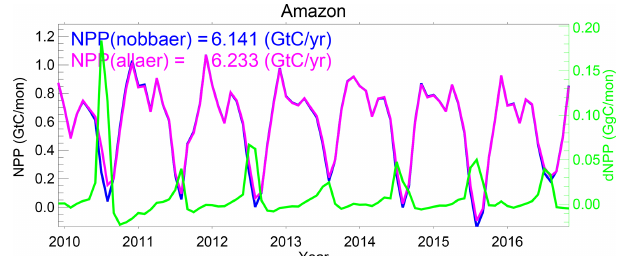
Figure 12. Monthly net primary product (NPP) over the Amazon Basin (i.e., the land area of 25 ◦ S–5 ◦ N, 80–30 ◦ W) for the allaer (magenta, solid) and nobbaer (blue, solid) GEOS simulations with the multiyear mean values indicated in the legend. The monthly dif- ference of NPP (dNPP = NPP(allaer) − NPP(nobbaer)) is shown by the green line and the right y